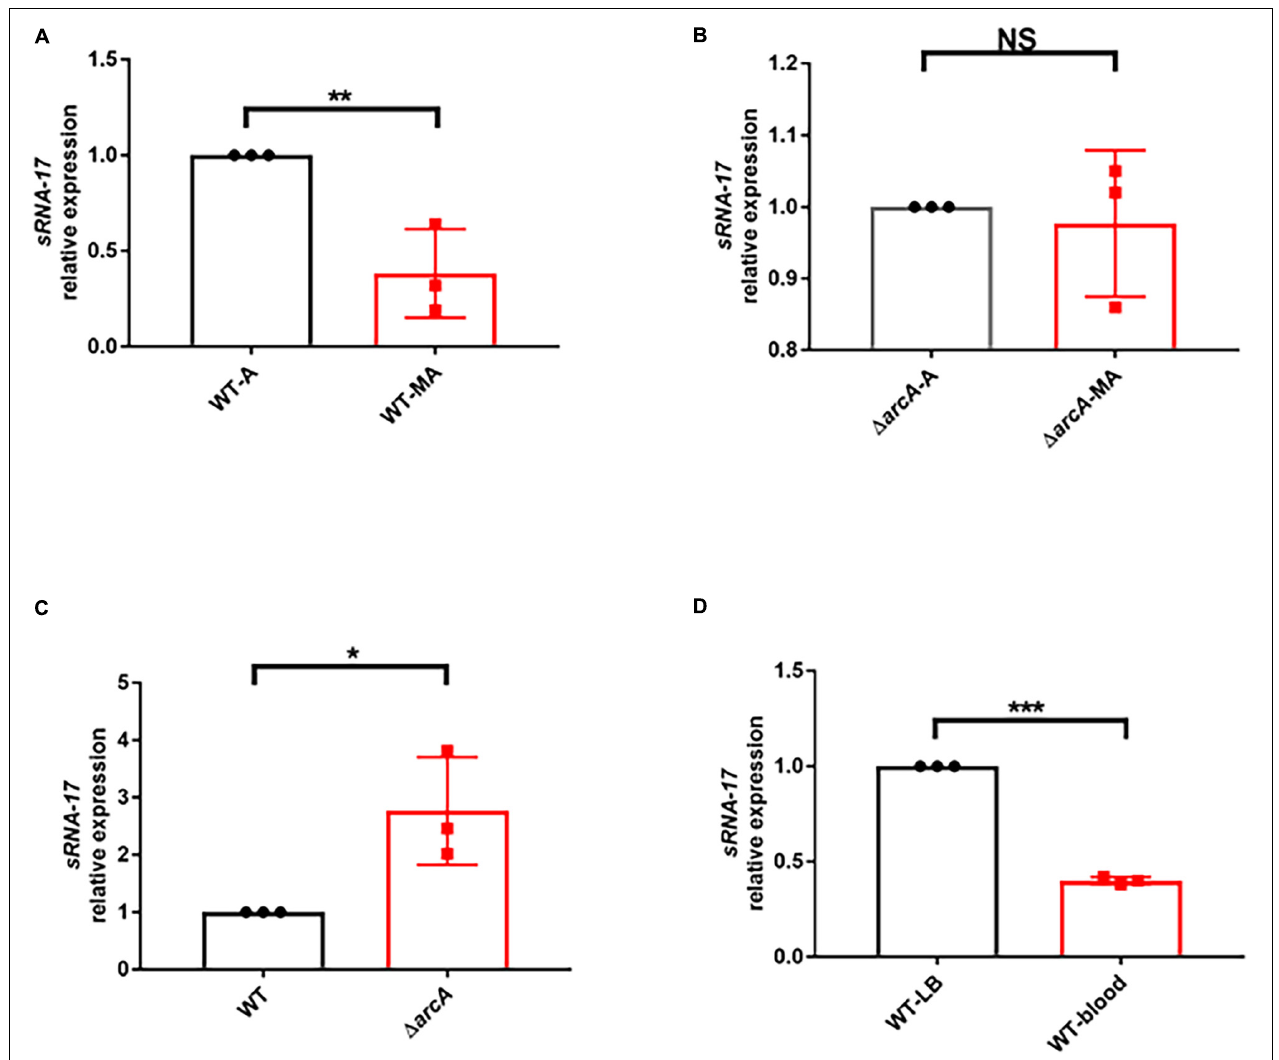
FIGURE 3 | The expression of sRNA-17 in RNA level by real-time PCR. (A) Fold change in the RNA levels of sRNA-17 in the wild-type strain in microaerophilic (WT-MA) and aerobic (WT-A) conditions. (B) Fold change in the RNA levels of sRNA-17 in (cid:49) arcA strain in microaerophilic ( (cid:49) arcA -MA) and aerobic ( (cid:49) arcA -A) conditions. (C) Fold change in the RNA levels of sRNA-17 in the wild-type and (cid:49) arcA strains. (D) Fold change in the RNA levels of sRNA-17 in Luria–Bertani (LB) medium and mouse blood by intravenous injection via the tail vein. * P < 0.05; ** P < 0.01; *** P < 0.001; NS, no significance, P >